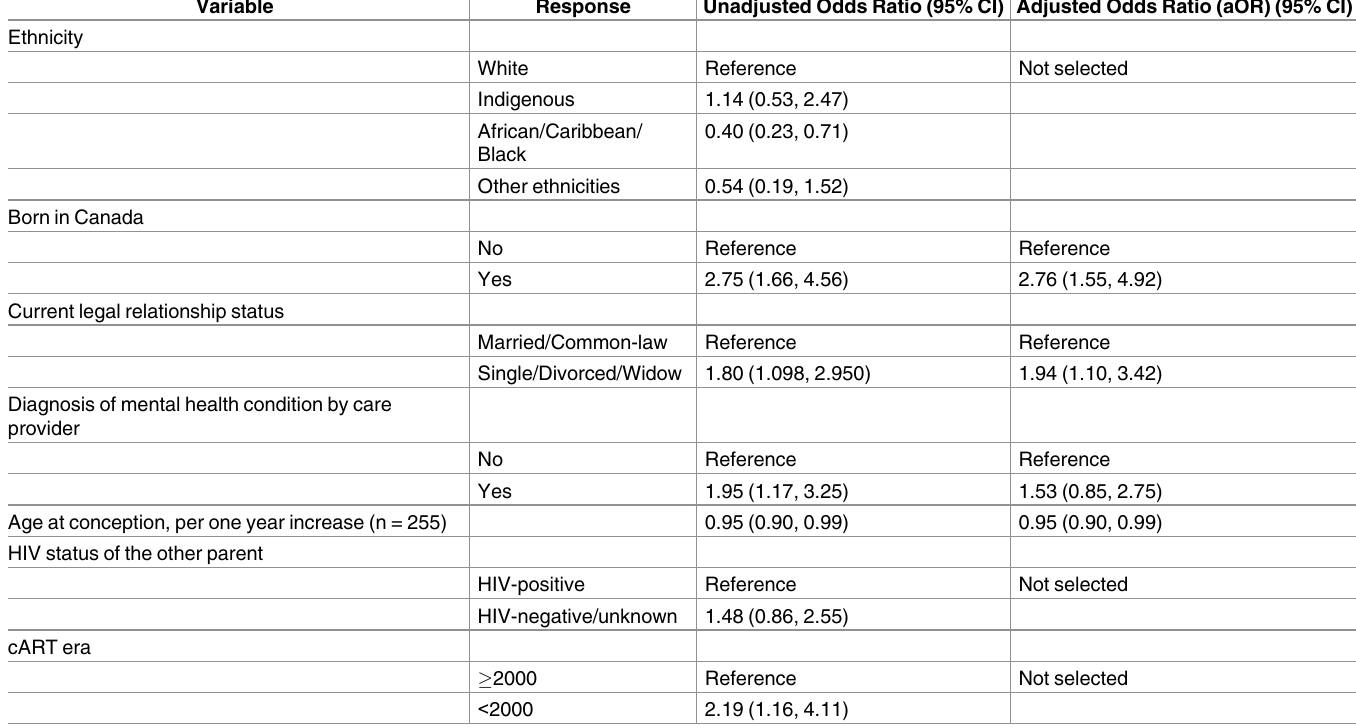
Table 4. Univariate and Multivariable model of factors associated with unintended (vs intended) pregnancy for most recent or current pregnancy, n =